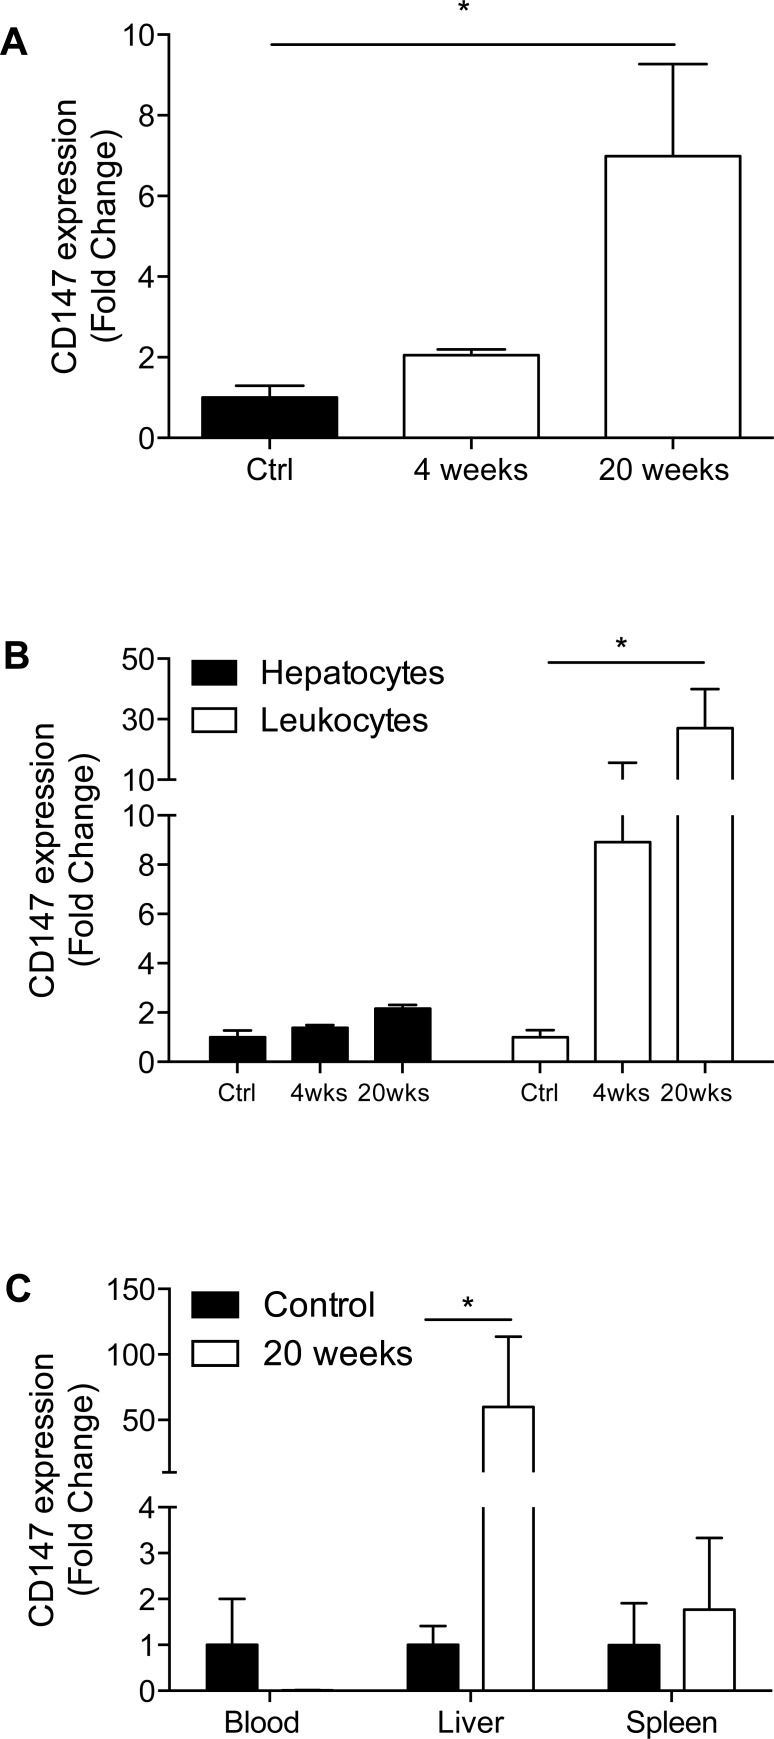
Quantitative real-time PCR for CD147 expression in a mouse model of TAA-induced liver injury.(A) CD147 expression in whole liver from control, 4 week and 20-week TAA-treated mice. (B) Comparison of CD147 expression in liver leukocytes and hepatocytes throughout the course of TAA-induced injury. (C) CD147 expression in blood, liver, and spleen at 20 weeks compared to control. Data were normalised to 18S and expressed as fold change from control. Bars represent mean +SEM. Mann-Whitney test was performed to assess significance from control where * p<0.05 (n = 5–7 per group).